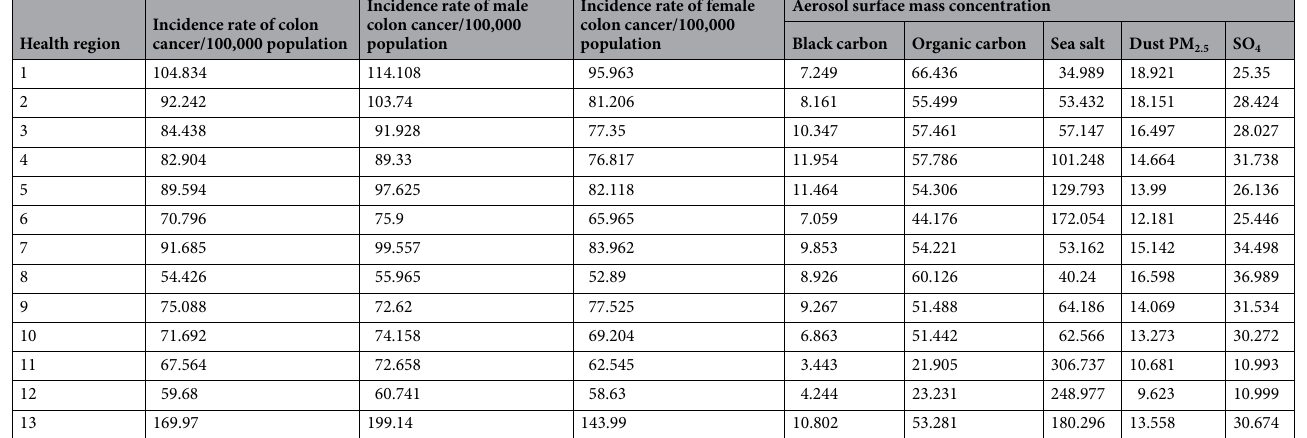
Table 1. Distribution of incidence rate of colon cancer in 2017 and accumulated aerosol surface mass concentration between 2010 and 2016.